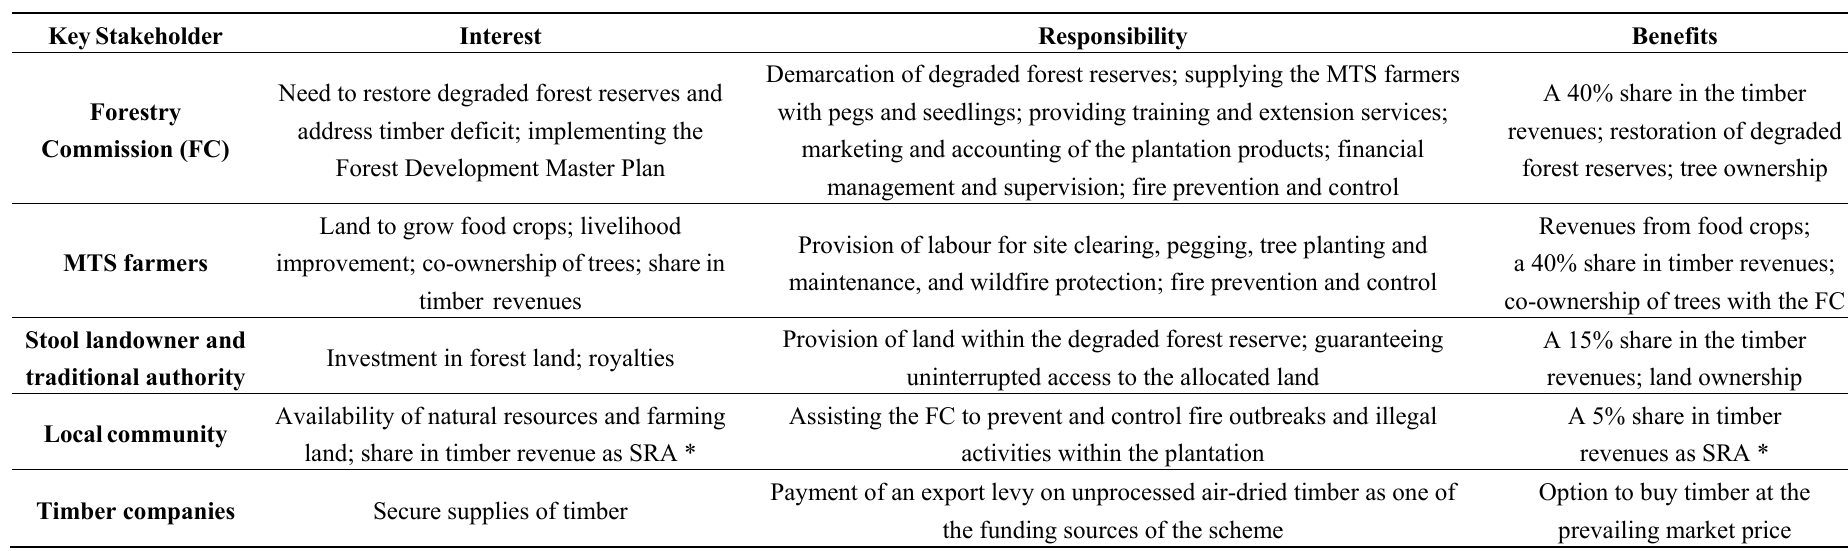
Table 4. MTS key stakeholders, their interest, responsibilities and